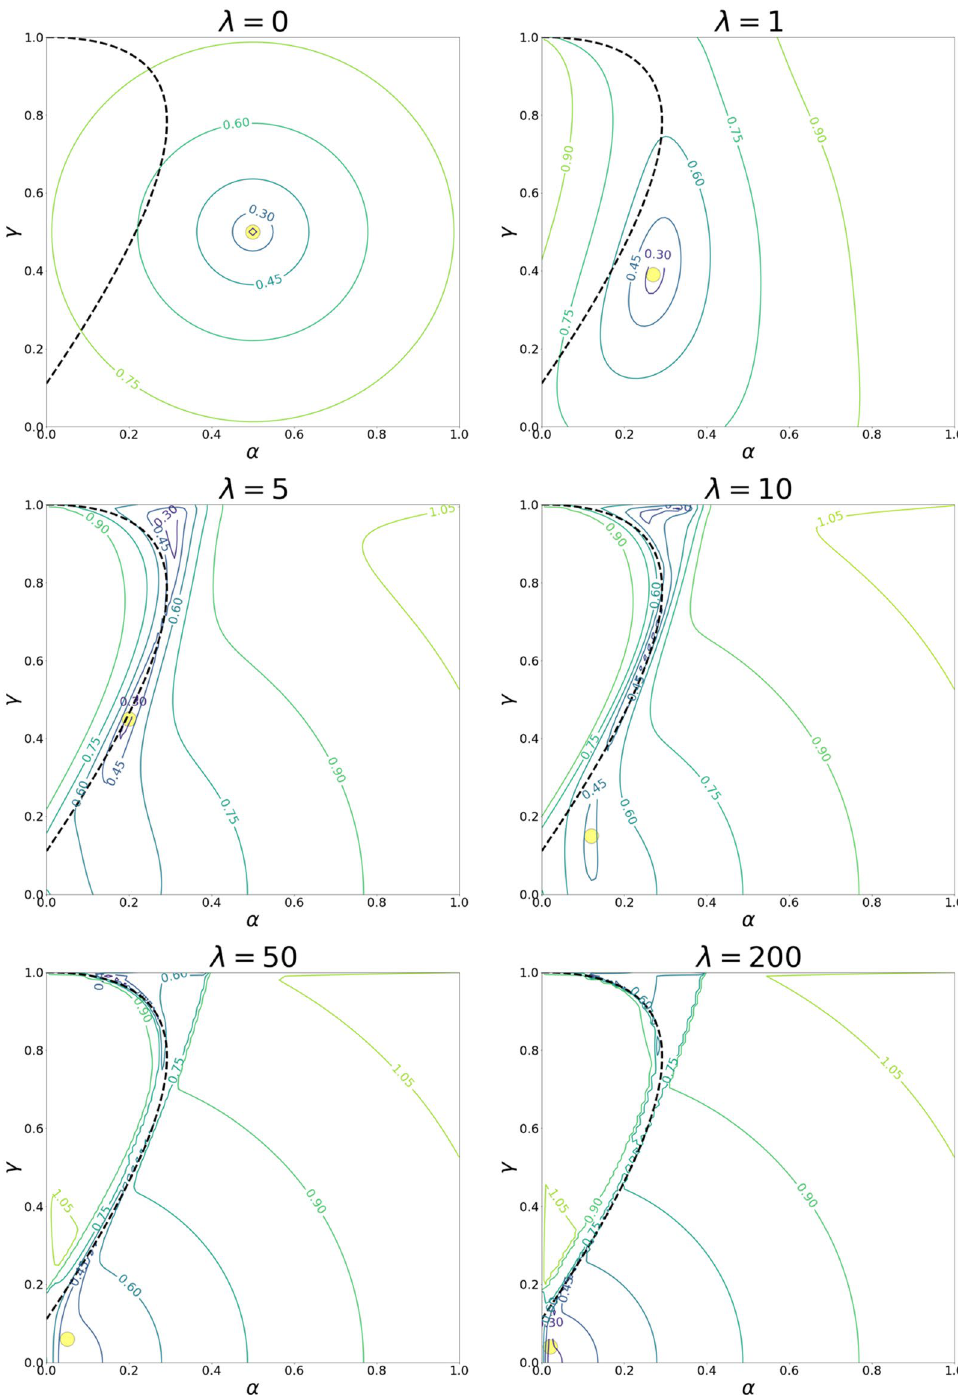
Figure 2. The panels plot contour lines of objective function (19) for different values of rationality (the objective function is shown to the power of 1/5 for demonstrative purposes). The dashed line represents the Nash equilibrium for PD in Markov strategies. The yellow circles symbolize solutions to corresponding optimization problem